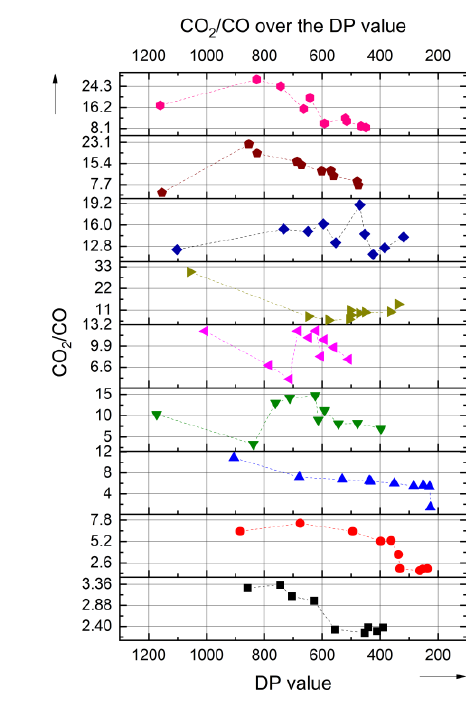
13 of 30 Figure 8. Change of CO 2 concentration for different sealing systems and fluids: ( a ) Change over the aging time; ( b ) Change over the DP value; the legends refer to Figure 6a. Usually, the CO 2 /CO ratio, which is supposed to be less sensitive to oil oxidation than the individual concentrations, is used to evaluate paper insulation. The curves of this ratio are presented in Figure 9. According to IEC 60599, the ratio for normal paper aging should be 3 < CO 2 /CO < 10 [47]. Values below 3 indicate above-average aging of the insulating paper, while values above 10 allow conclusions to be drawn about mild overheating of the insulation (>160 °C) [48]. In [46], an increasing ratio between 6–9.5 of CO 2 /CO for a